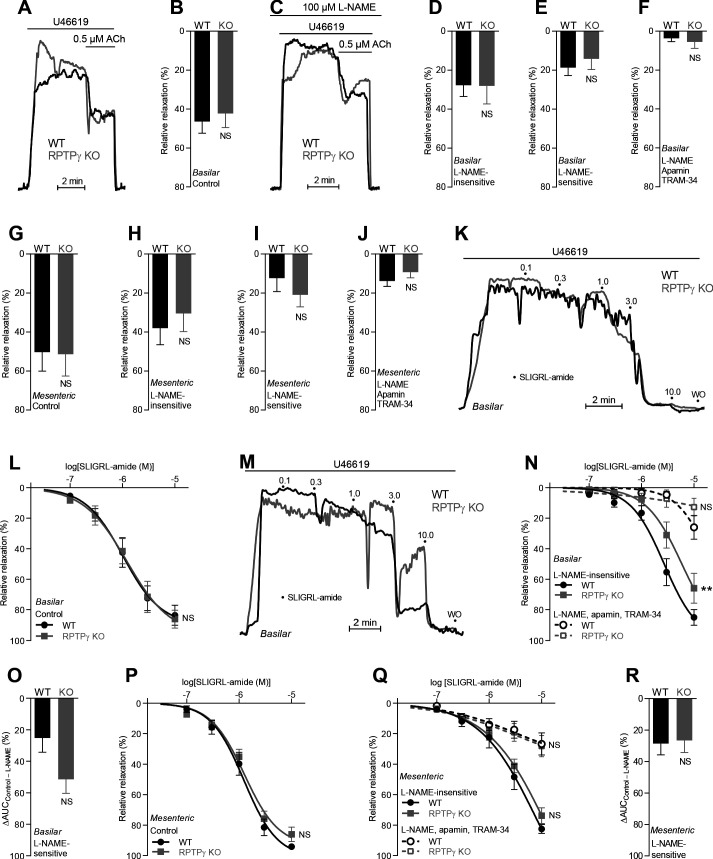
In absence of CO2/HCO3–, acetylcholine (ACh)- and SLIGRL-amide-induced endothelium-dependent vasorelaxation of basilar and mesenteric arteries is similar between RPTPγ KO and WT mice.(A and C) Force recordings illustrating acetylcholine-induced vasorelaxation of U46619-contracted basilar arteries under control conditions (A) and after treatment with 100 µM L-NAME (C). The pre-contraction force development in response to U46619 was normalized in order to display relative relaxations. (B and G) Acetylcholine-induced relaxations of basilar (B, n = 11) and mesenteric (G, n = 6–7) arteries from RPTPγ KO and WT mice under control CO2/HCO3–-free conditions, that is, without inhibitors of endothelial function. (D and H) Acetylcholine-induced relaxations of basilar (D, n = 11) and mesenteric (H, n = 6–7) arteries from RPTPγ KO and WT mice in presence of 100 µM L-NAME under CO2/HCO3–-free conditions. (E and I) Acetylcholine-induced L-NAME-sensitive relaxations of basilar (E, n = 11) and mesenteric (I, n = 6–7) arteries from RPTPγ KO and WT mice calculated as the difference between relaxations with and without L-NAME. Experiments were performed in absence of CO2/HCO3–. (F and J) Acetylcholine-induced relaxations of basilar (F, n = 11) and mesenteric (J, n = 6–7) arteries from RPTPγ KO and WT mice after treatment with 100 µM L-NAME, 50 nM apamin, and 1.0 µM TRAM-34 under CO2/HCO3–-free conditions. (K and M) Force recordings illustrating SLIGRL-amide-induced vasorelaxation of U46619-contracted basilar arteries under control conditions (K) and after treatment with 100 µM L-NAME (M). The numbers indicate points of cumulative stepwise increases in SLIGRL-amide from 0.1 µM to 10.0 µM. WO indicates the point of washout. The pre-contraction force development in response to U46619 was normalized in order to display relative relaxations. (L and P) SLIGRL-amide-induced relaxations of basilar (L, n = 10) and mesenteric (P, n = 6–7) arteries from RPTPγ KO and WT mice under control CO2/HCO3–-free conditions, that is, without inhibitors of endothelial function. (N and Q) SLIGRL-amide-induced relaxations of basilar (N, n = 10) and mesenteric (Q, n = 6–7) arteries from RPTPγ KO and WT mice after treatment with 100 µM L-NAME alone or in combination with 50 nM apamin and 1.0 µM TRAM-34. The experiments were performed in absence of CO2/HCO3–. (O and R) SLIGRL-amide-induced L-NAME-sensitive relaxations of basilar (O, n = 10) and mesenteric (R, n = 6–7) arteries from RPTPγ KO and WT mice calculated as the difference in area under the curve (AUC) between the concentration-response curves with and without L-NAME. In panels A-J, we applied a concentration of 0.5 µM acetylcholine. Data in panels B, E, G-J, and O were compared by unpaired two-tailed Student’s t-tests, data in panels D and R by non-parametric Mann-Whitney test, and data in panel F by unpaired two-tailed t-test with Welch’s correction. In panels L, N, P, and Q, the relative relaxations were fitted to sigmoidal curves and compared using extra sum-of-squares F tests. Data in panel J were log-transformed before comparison. **p<0.01, NS: not significantly different vs WT.